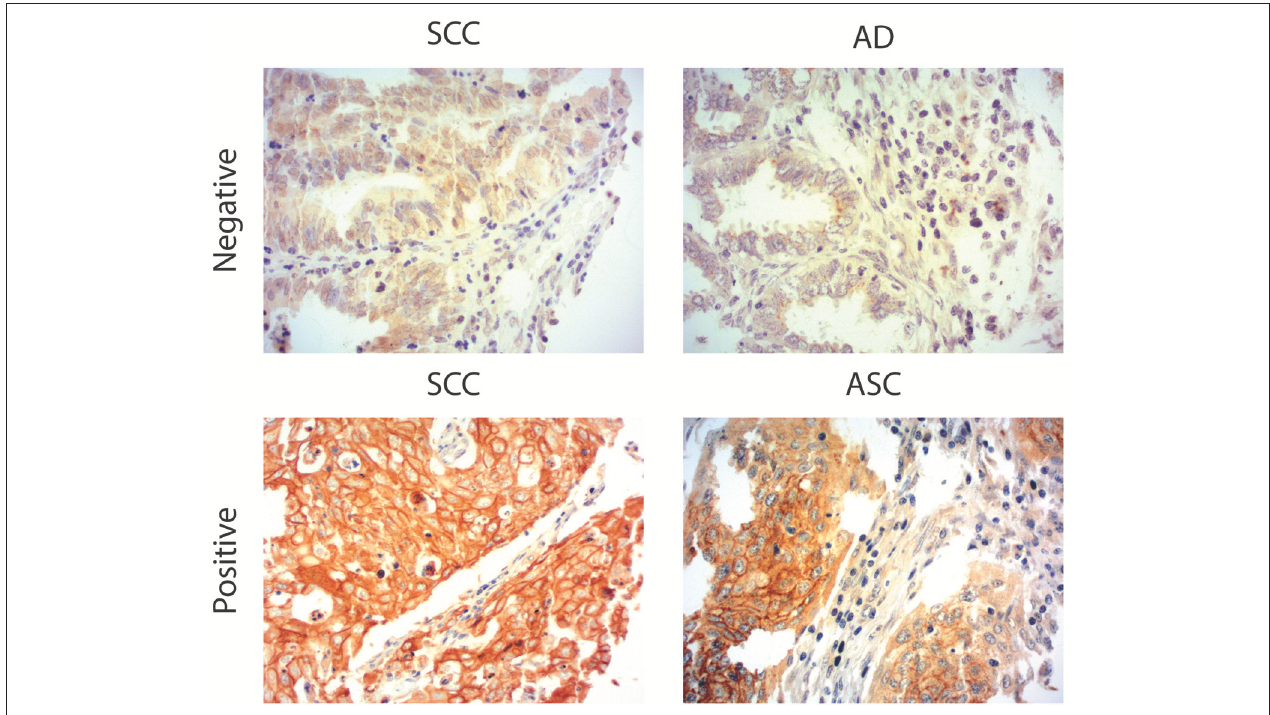
FIGURE 1 | MGL ligand expression in cervical cancer. Representative images of Squamous Cell Carcinoma (SCC), Adenosquamous carcinoma (ASC), and adenocarcinoma (AC) cervical cancer tissues stained with a chimeric MGL-mouseFc protein. MGL ligand expression was labeled positive or negative/weak based on the intensity of MGL-mouseFc binding. Magnification